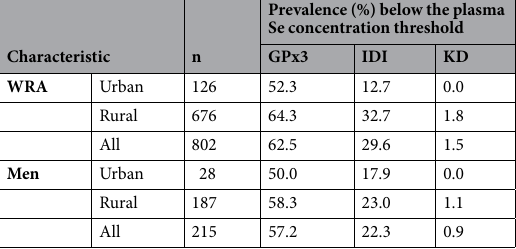
Table 2. Prevalence of selenium (Se) deficiency among women of reproductive age (WRA, aged 15–49 years) and men (aged 20–54 years) in Malawi, based on plasma Se concentration thresholds for optimal activity of glutathione peroxidase 3 (GPx3; < 84.9 ng mL − 1 ), iodothyronine deiodinase (IDI; < 64.8 ng mL − 1 ), and for Keshan Disease (KD; < 30 ng mL − 1 ) which is a cardiomyopathy linked to Se status reported in China. Thresholds from Thomson (ref. 9